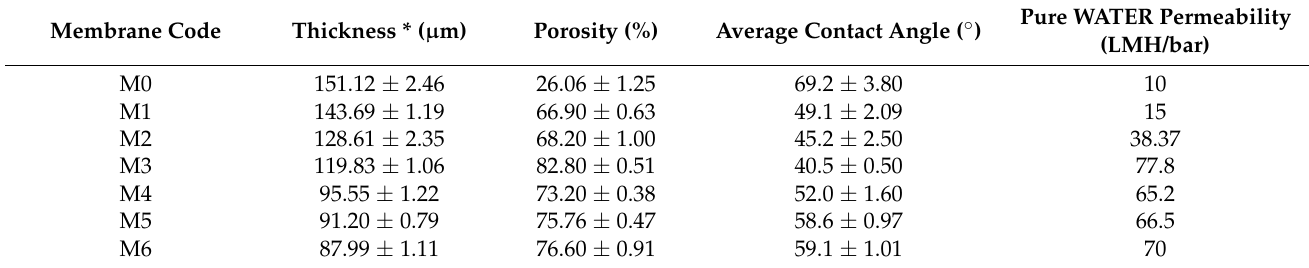
Table 2. Effect of MCM-41 wt.% on the porosity, water contact angle, and water permeability of PES membranes. Membrane Code